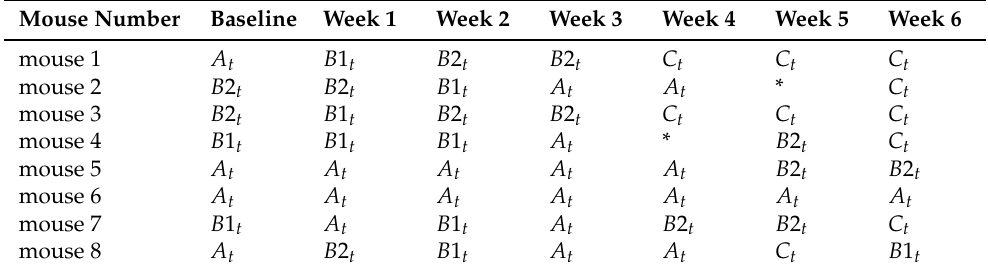
Table 5. Evolutionary path of sunitinib-treated mice of the training set. Items marked as * indicate missing classification due to the absence of corresponding PETRUS data. Clusters that were assigned by the RF model are underlined.